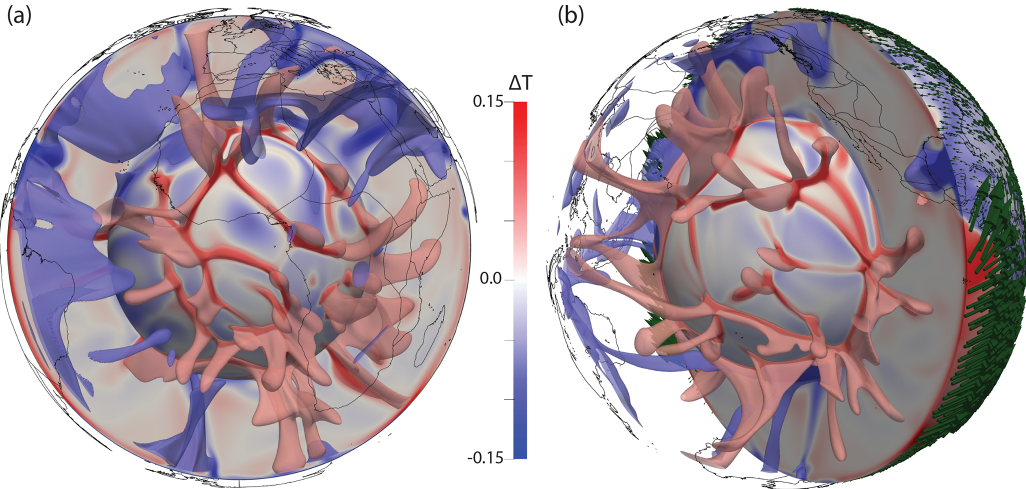
Figure 11. Present-day thermal structure, predicted from our global mantle convection simulation where the geographic distribution of heterogeneity is dictated by 230Myr of imposed plate motion history (Müller et al., 2016). Each image includes a radial surface at r = 1 . 25 (i.e. immediately above the core–mantle boundary), a cross section and transparent isosurfaces at temperature anomalies (i.e. away from the radial average) of T = − 0 . 075 (blue) and T = 0 . 075 (red), highlighting the location of downwelling slabs and upwelling mantle plumes (below r = 2 . 13) respectively. Continental boundaries provide geographic reference. Panel (a) provides an Africa-centred view, with panel (b) centred on the Pacific Ocean and including (green) glyphs at the surface highlighting the imposed plate